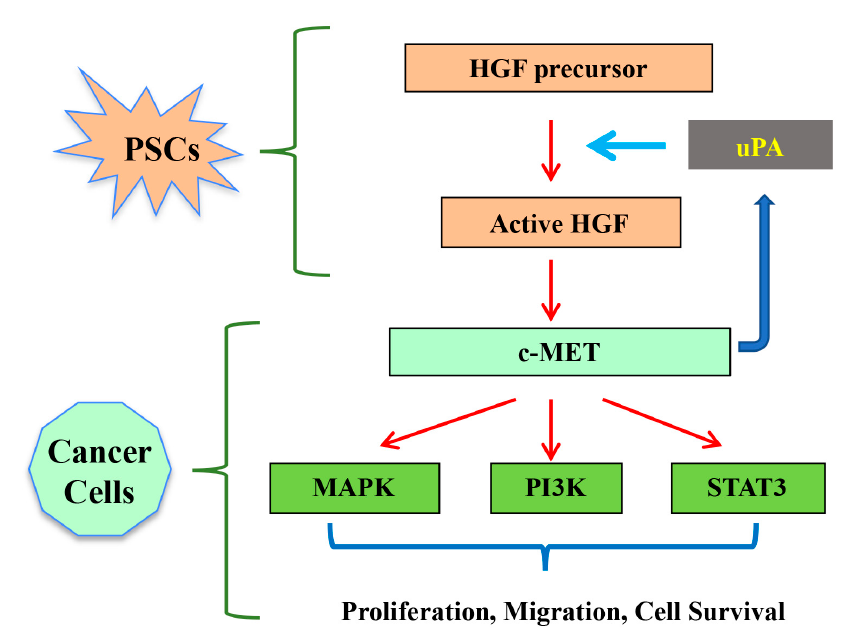
Figure 3. Schematic depiction of the possible role of HGF / c-MET pathway in pancreatic cancer. HGF secreted by PSCs in a precursor form is activated by proteolytic cleavage, mediated by proteases such as urokinase plasminogen activator (uPA). Upon binding of HGF to its receptor c-MET, downstream intracellular signalling cascades are activated which regulate cancer cell functions that influence tumour progression. This binding also increases production of uPA by cancer cells that further activates HGF from PSCs, thus forming a feed-forward loop. Adapted from Pothula et al. [53].